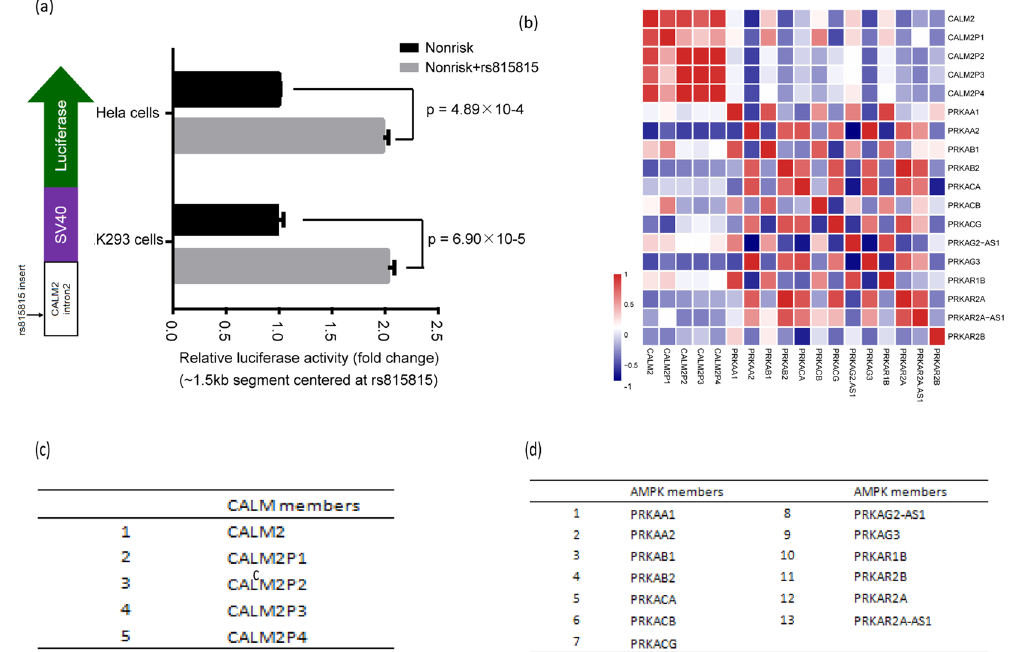
Figure 6. Aberrant gene expression of CALM2 caused by rs815815. ( a ) The risk allele of rs815815 (allele A) shows greater enhancer activity than the non-risk allele (allele G) in HeLa cells and HEK293 cells. The relative expression of each allele was normalized to the total expression of CALM2 (black bars). For each cell line, the s.d. values were calculated from three independent clones for each allele. The p values were calculated by two- sided t-test. ( b ) CALM family genes. ( c ) AMPK family genes. ( d ) Calmodulin and AMPK families present negative correlation pattern in expression in tissues relevant to the development of diabetes. The value in the heatmap indicates the correlation coefficient (Pearson’s